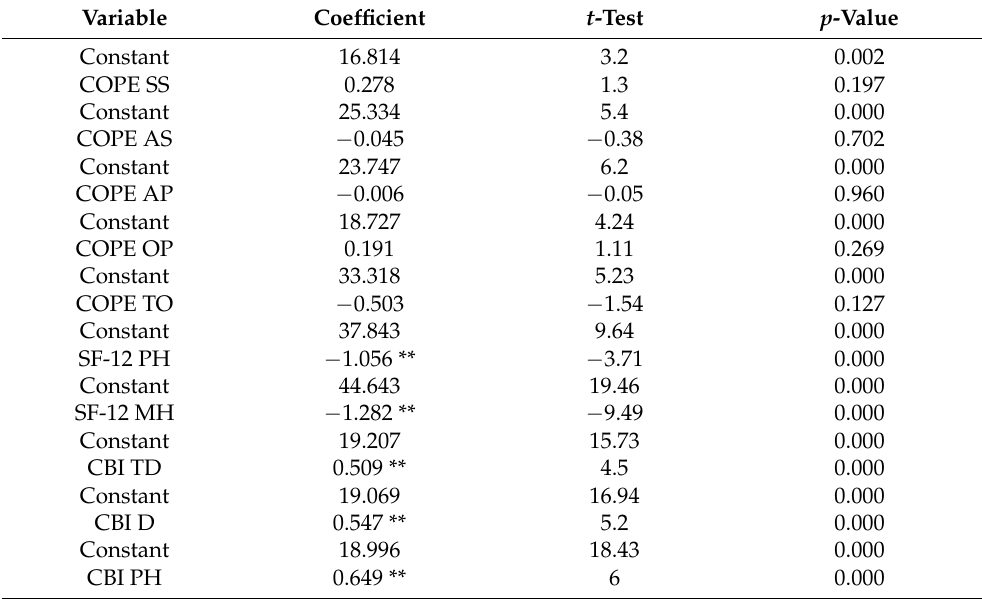
Table 4. Univariate regression models for a perceived level of stress